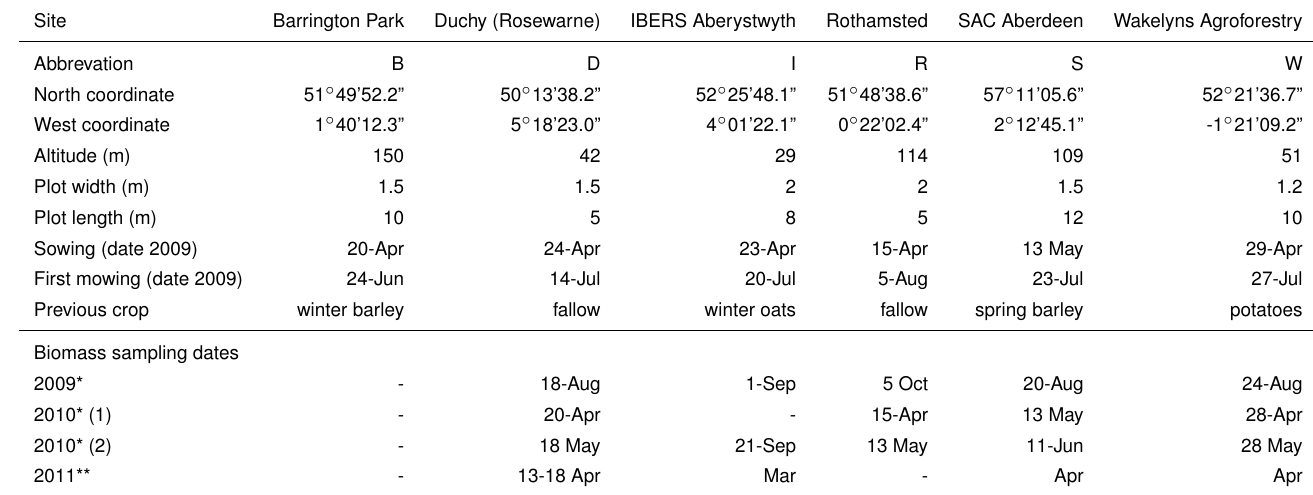
Table 2. Details of replicated trials: locations, plot sizes, sowing dates and pre-crops; * taken from one quadrat (50 × 50 cm) per plot; ** taken from three quadrats (each 50 × 50 cm) per plot.